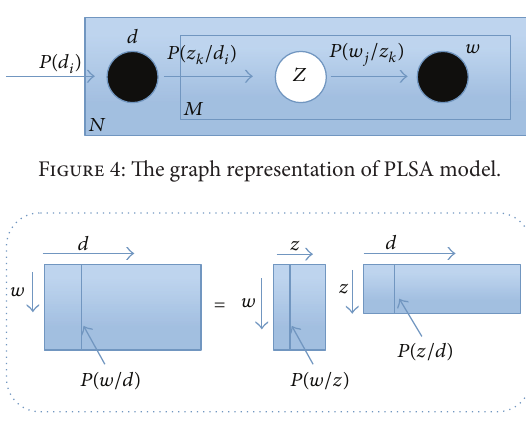
Figure 5: The matrix decomposition of PLSA